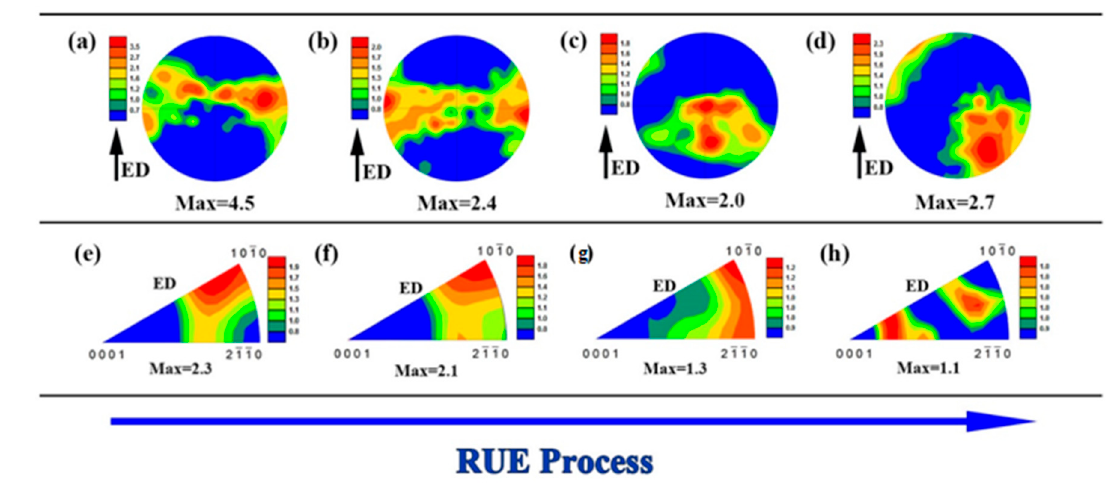
Figure 7. Texture development during RUE:(0001) pole figures ( a – d ) and corresponding inverse pole